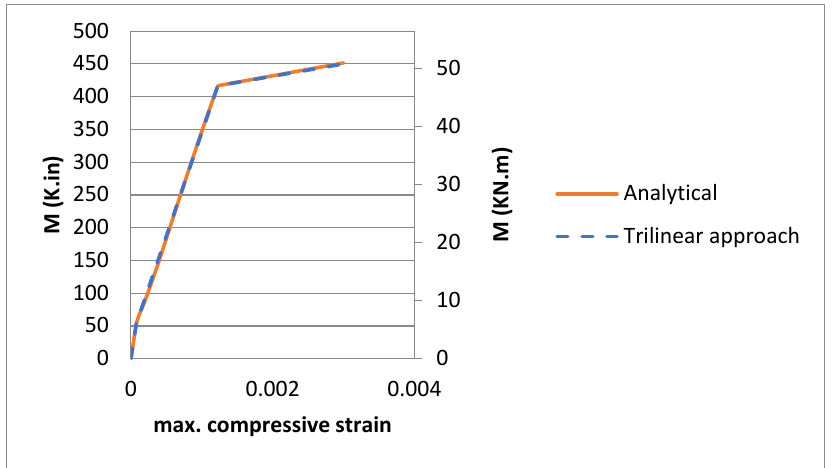
Figure 22. Decker (2007) [18] moment vs. maximum compressive strain analytical graphs.